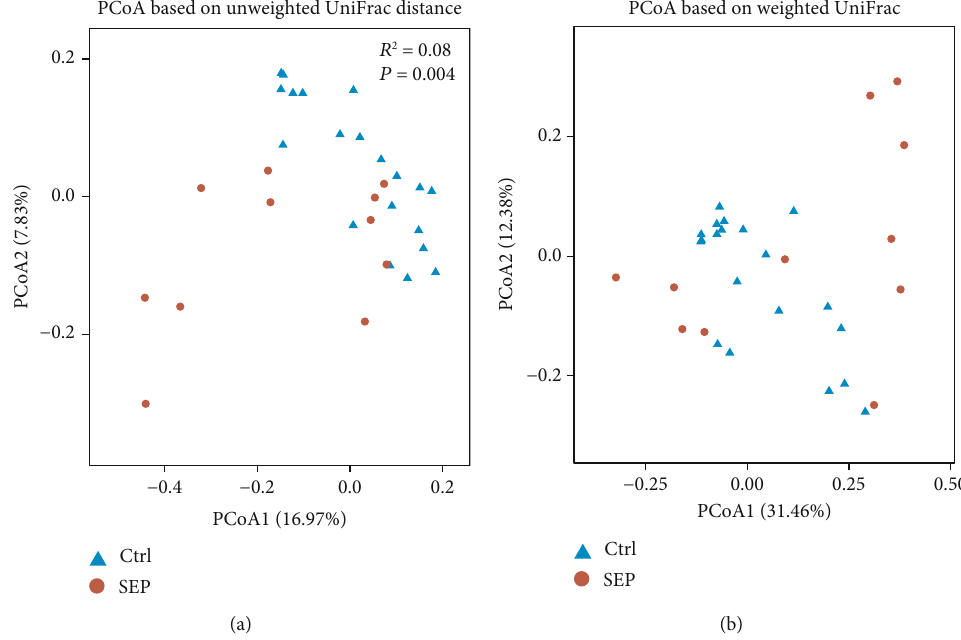
Figure 2: Principal coordinate analysis (PCoA) plot based on unweighted and weighted UniFrac distances with PERMANOVA analysis. (a). The PCoA plot based on unweighted UniFrac distance. (b). The PCoA plot based on weighted UniFrac